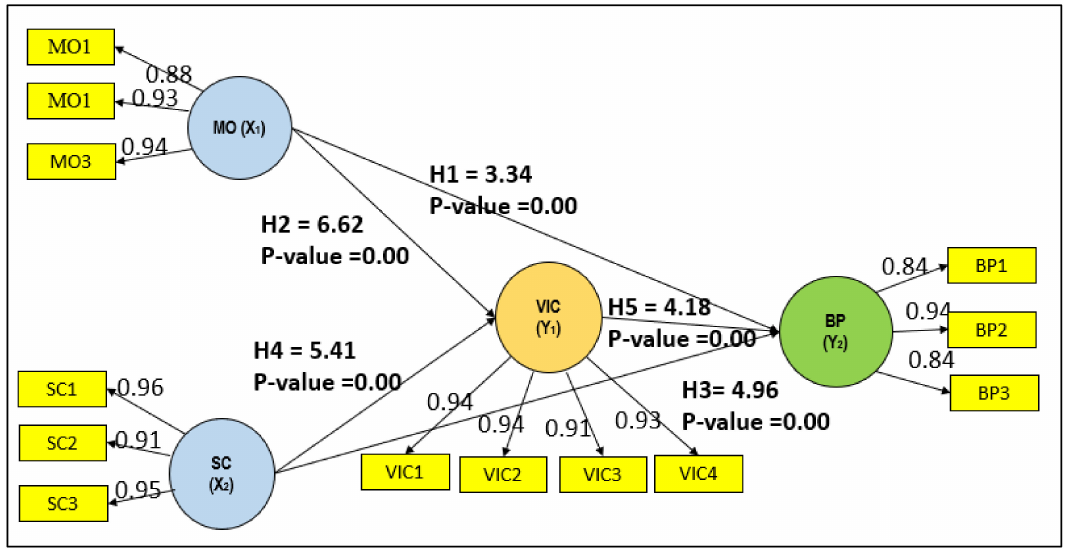
Figure 2. Results of the empirical research model. Source: author